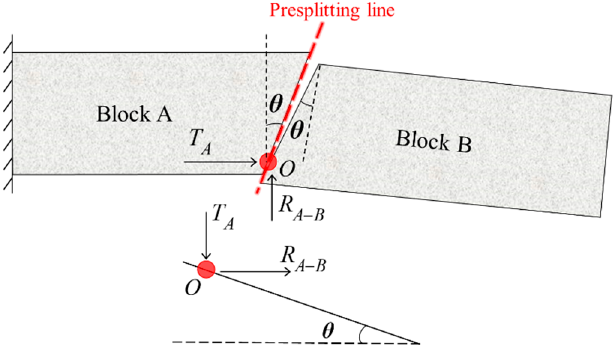
Figure 8. Presplitting rock blocks mechanical model.